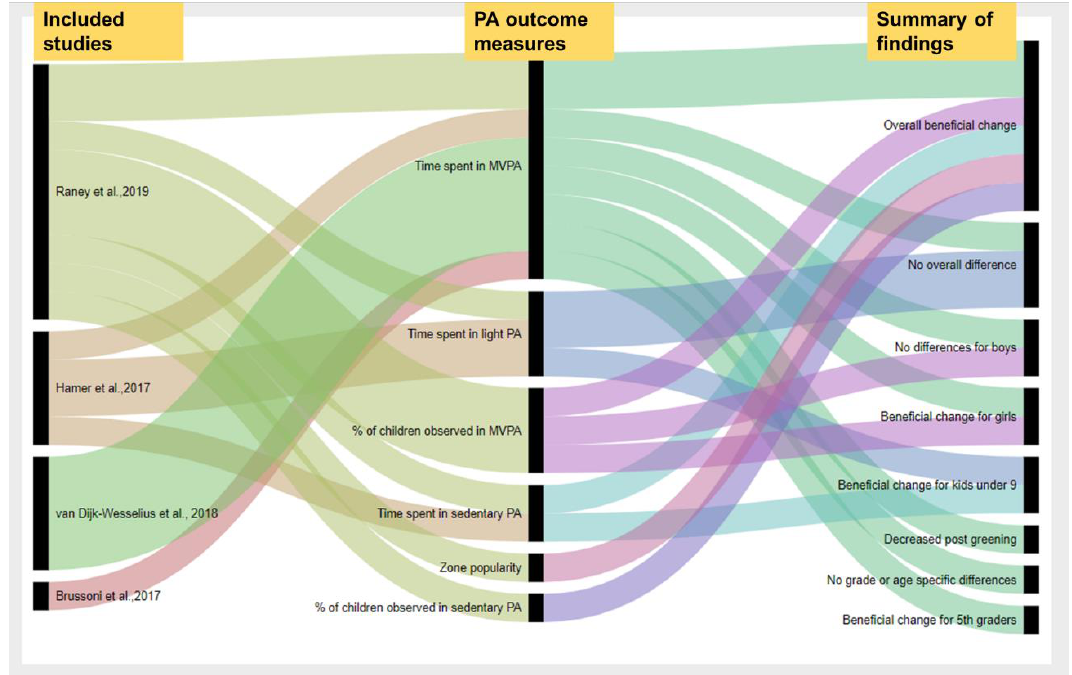
Figure 2. The impact of schoolyard greening on physical activity outcomes: The first column represents the authors, the second column represents the physical activity (PA) outcome measures, while the third column represents the summary of findings for each outcome. This graphical representation shows an overall trend in findings across studies.